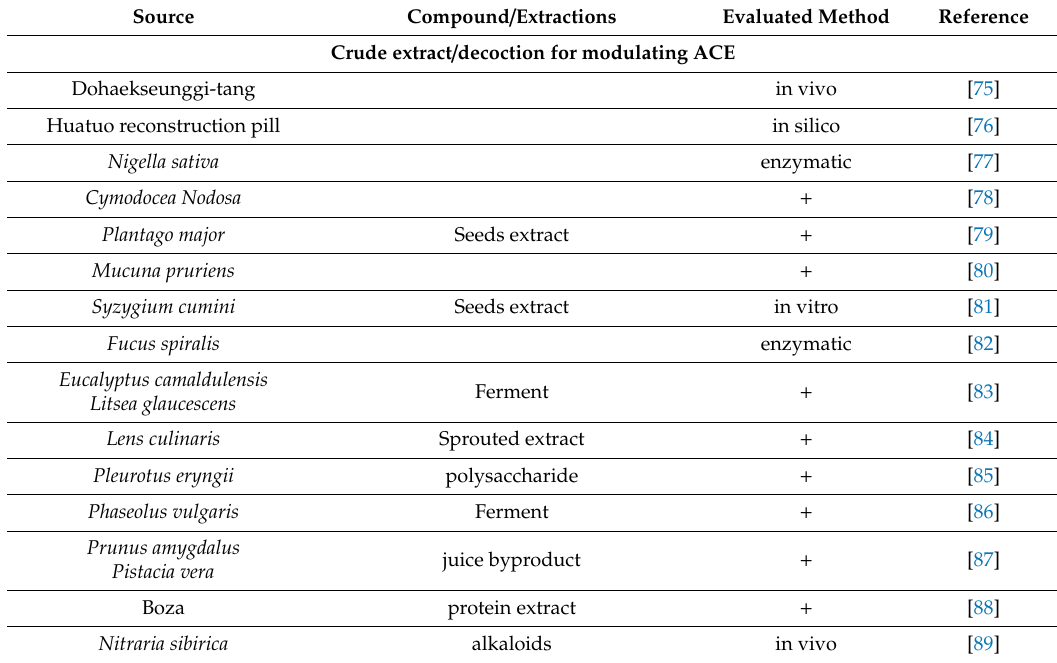
Table 2. RAAS modulators from natural